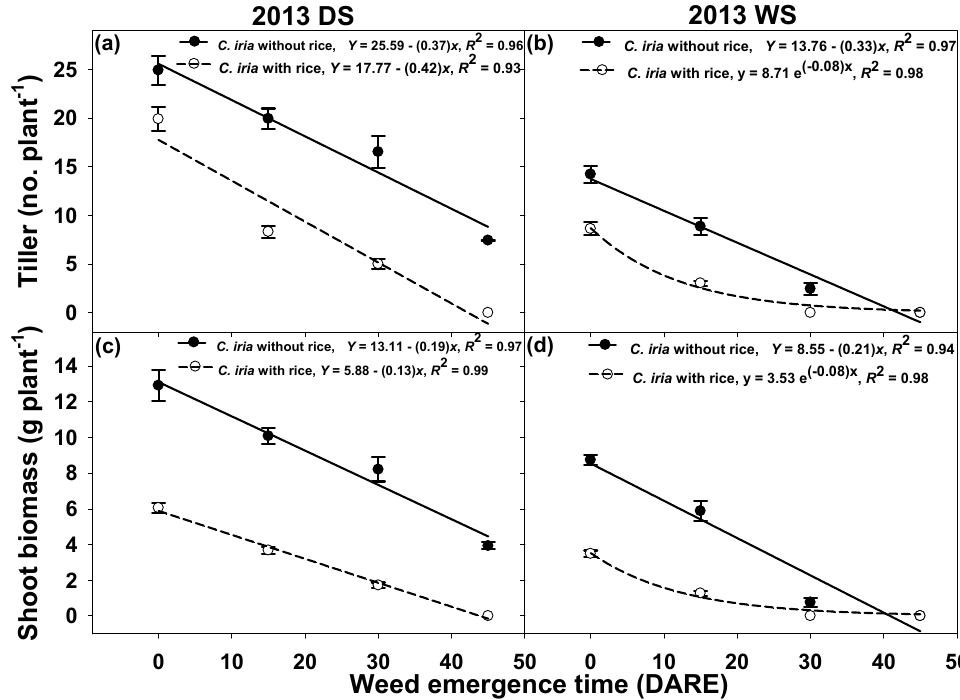
Figure 3. Regression curves ( y = a + bx and y = a. e – bx ) fitted to the tiller number ( a , b ) and shoot bio- mass ( c , d ) of C. iria . Models fitted to the data for C. iria grown without rice interference (Rice 0) are shown by solid lines, and those fitted to the data for C. iria grown with rice at the rate of a 50 kg ha – 1 seed rate (Rice 50) are shown by broken lines. Equations represent the estimated parameters, and the standard error of the means is represented by vertical